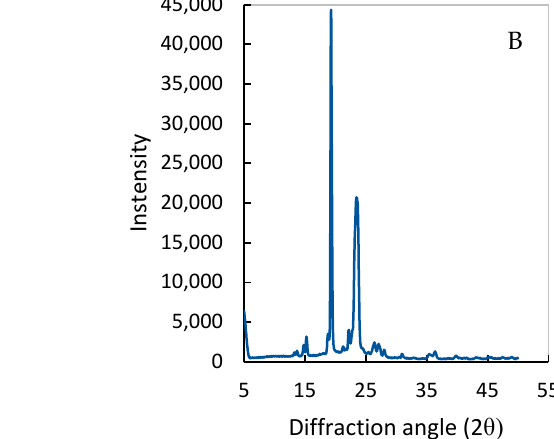
Figure 1. Powder X-ray diffraction pattern of pure Moringa oleifera leaf powder (MOLP). Figure 1. Powder X ‐ ray diffraction pattern of pure Moringa oleifera leaf powder (MOLP).